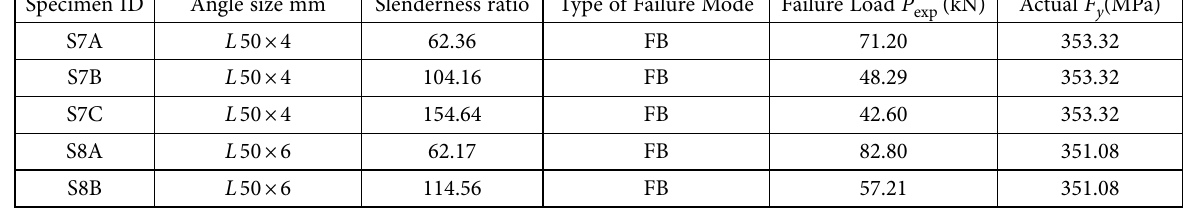
Table 9. Experimental test result for welded angle specimens